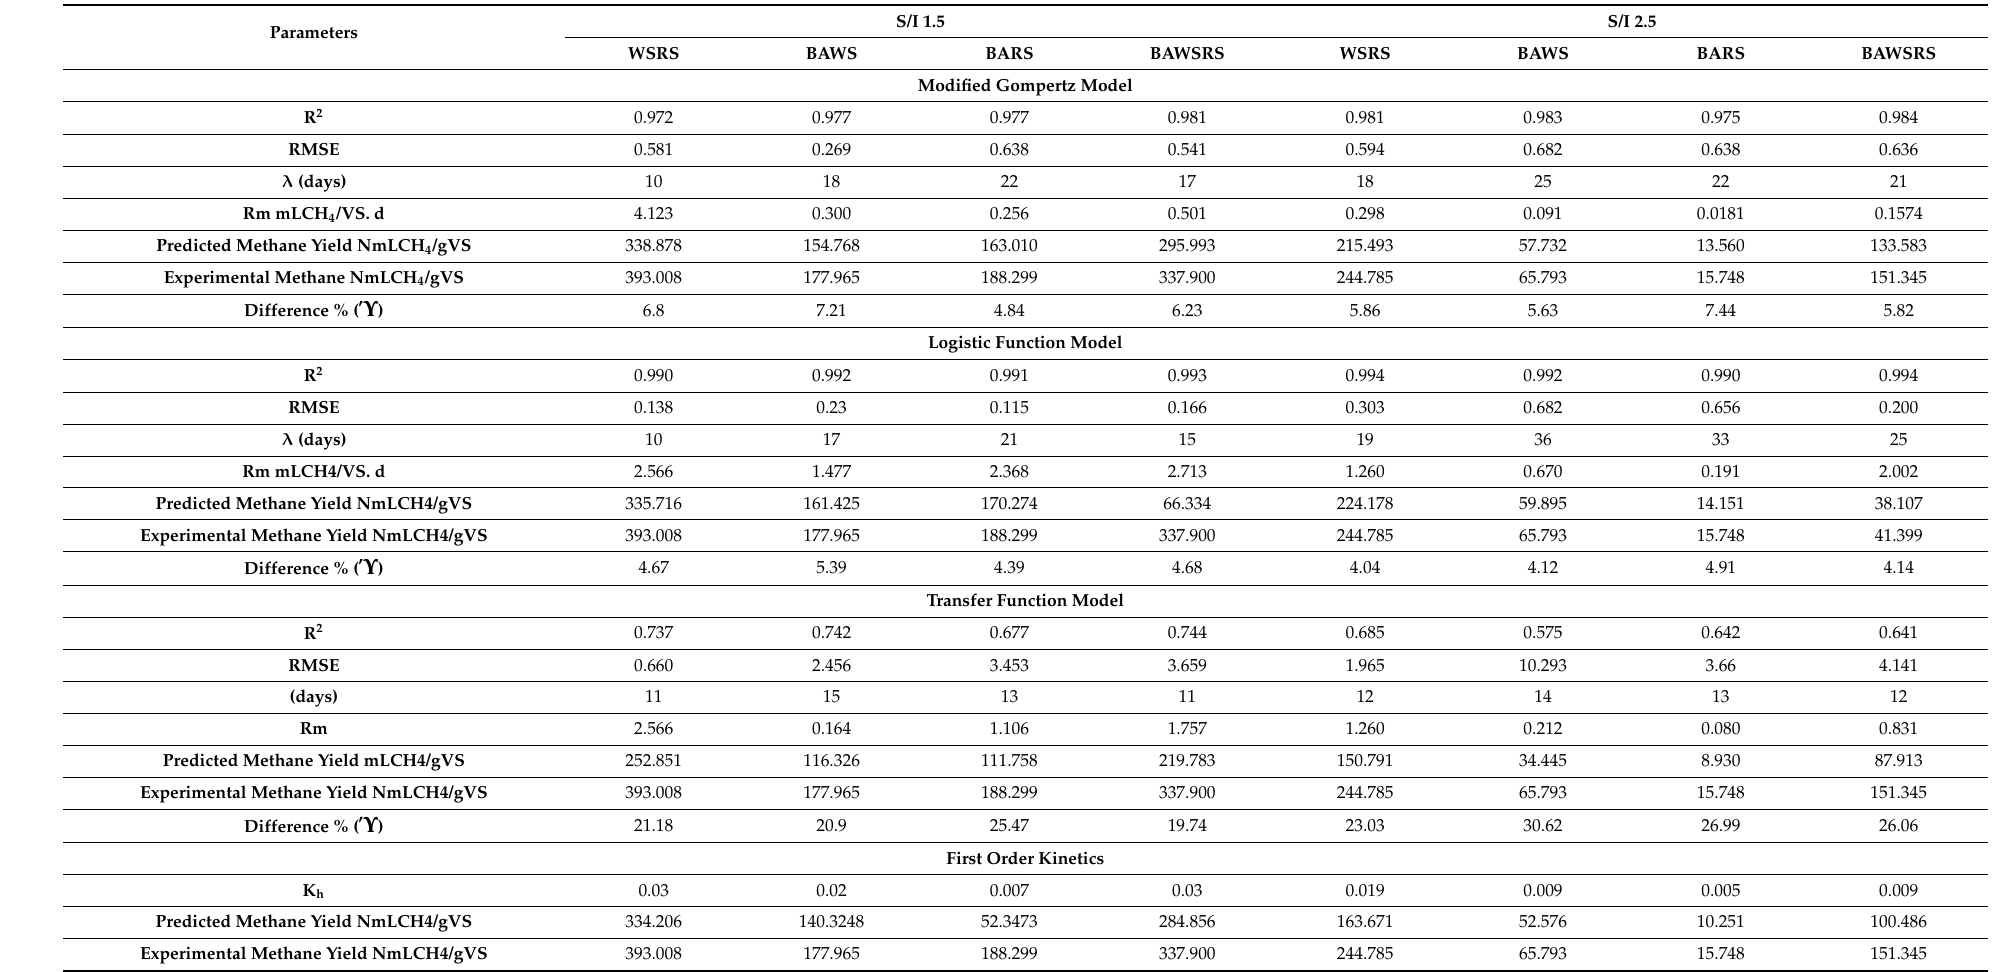
Table 4. Summary of Kinetic Parameters.